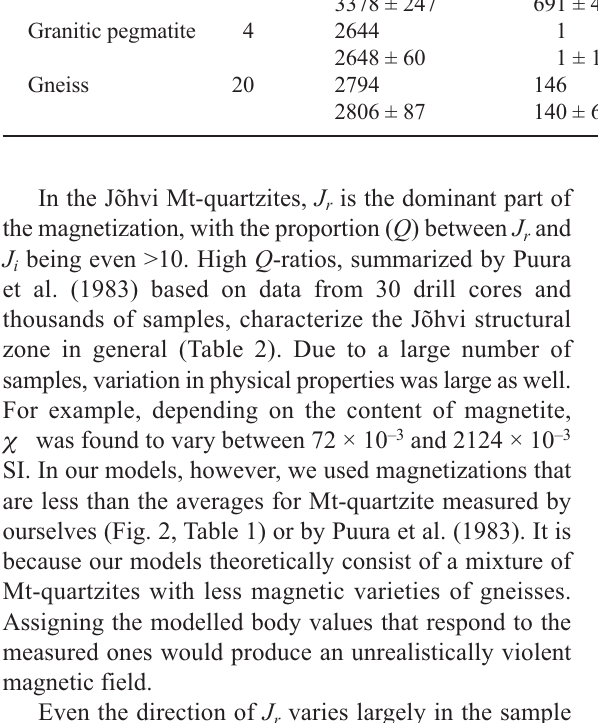
Table 2. Magnetic properties of the Jõhvi structural zone after Puura et al (1983)